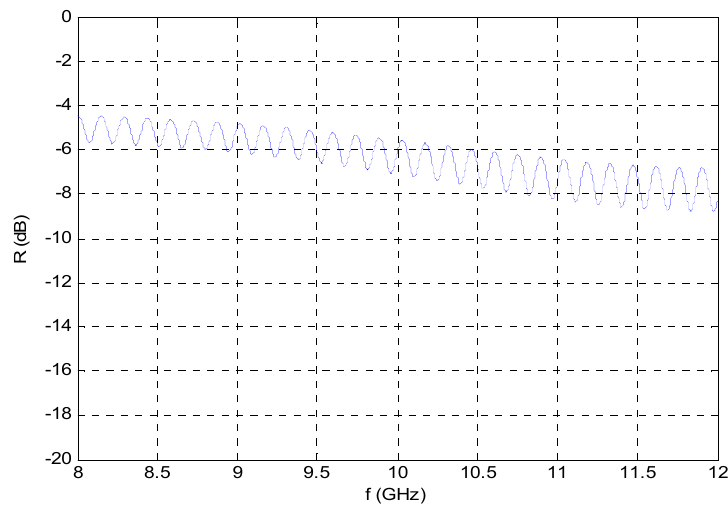
Figure 8. Simulation results without the glass (mosaic) layer.